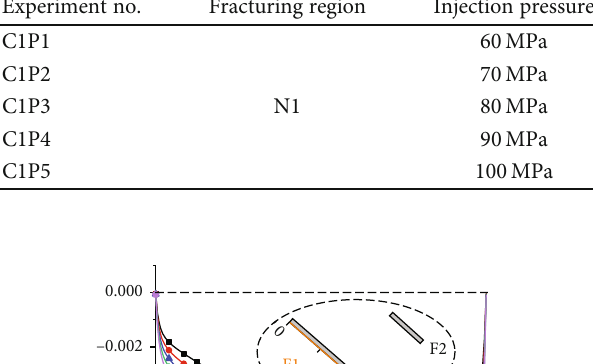
Table 8: Numerical experiments according to di ff erent injection pressures. Experiment no.